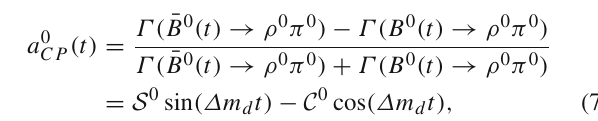
where C i and S i are direct and mixing-induced C P asym- metries, respectively, and the subscript i refers to the charge of the emitted ρ i